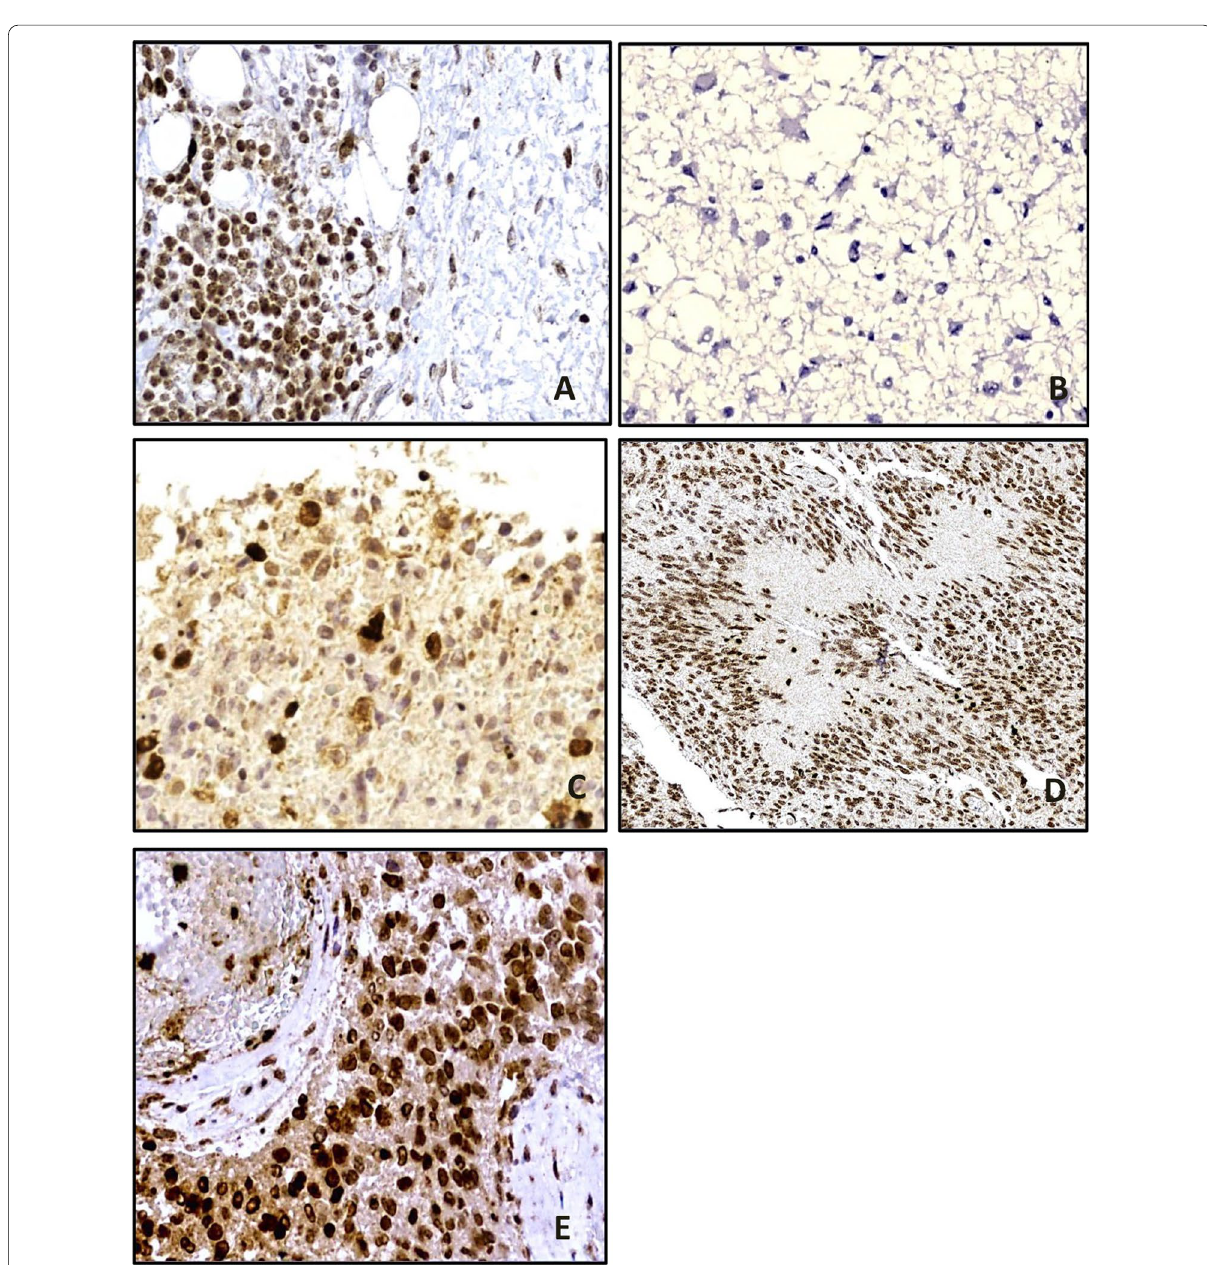
Fig. 2 HIF-1 α immunohistochemistry positive control (breast invasive duct carcinoma), 400 ( A ). Astrocytoma, IDH1 mutant, WHO grade 2, × negative HIF1 α immunohistochemistry, 400 ( B ). Astrocytoma, IDH1-mutant, WHO grade 3 with abnormal mitosis, HIF1-α positive nuclear staining × (score 2), 400 ( C ). Astrocytoma, IDH1-mutant, WHO grade 4, HIF1 α positive, palisading necrosis (score-3) 200 ( D ). Glioblastoma NOS, WHO grade × × 4. HIF1α positive nuclear staining. Cells around blood vessels 400 ( E ×